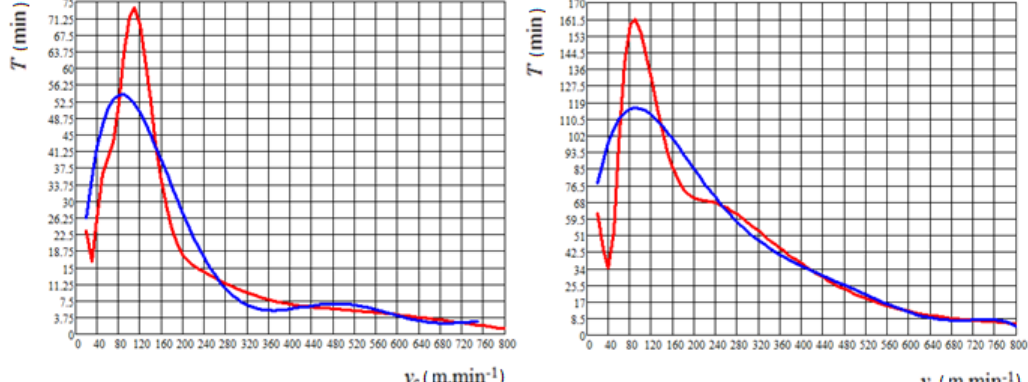
Figure 11. Regression analysis of T-v c dependence for P20 ( left ) and P20+TiN ( right )—conventional lathe (red curve—values obtained from the experiment; blue curve—values determined in accordance with ISO 3685).